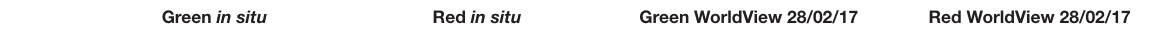
TABLE 2 | Snow algae in situ data.